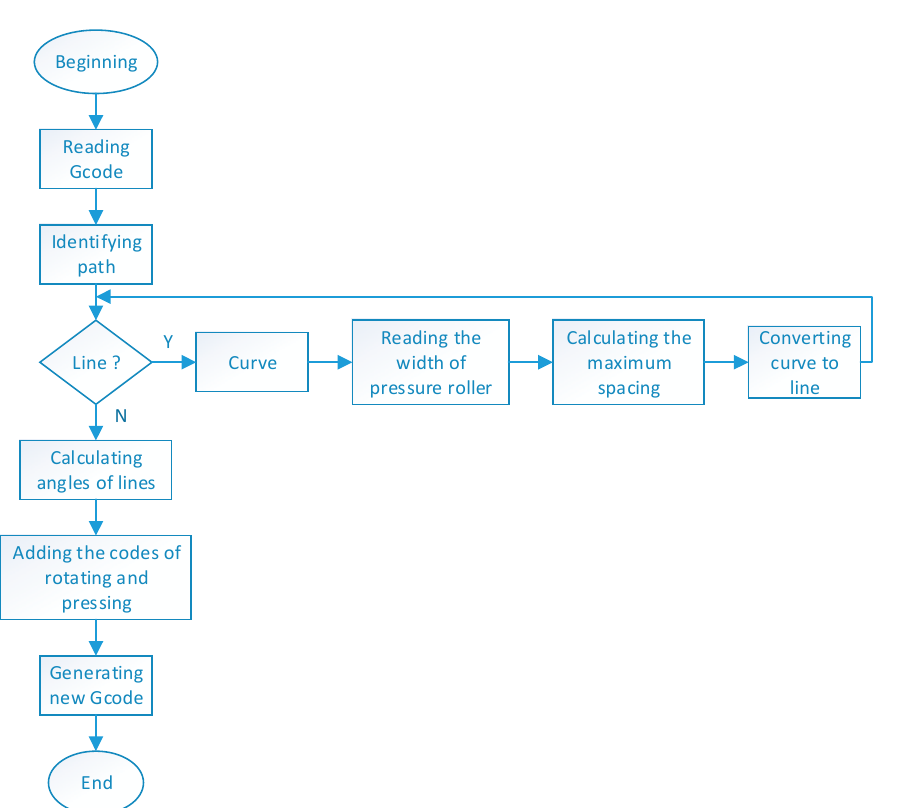
Figure 3. The flow chart for path processing of the pressure roller.